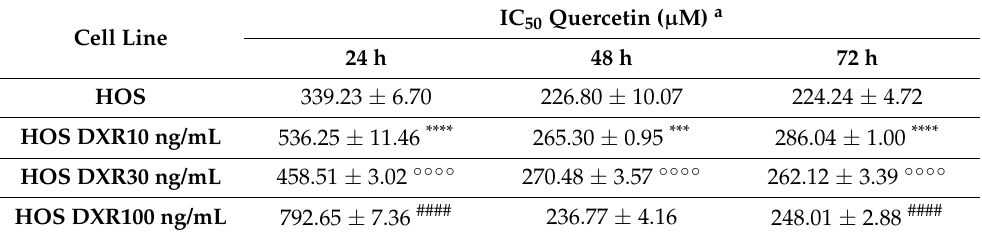
Table 2. Cytotoxic effect of quercetin (calculated as IC 50 ) after 24, 48, and 72 h of treatment in HOS,